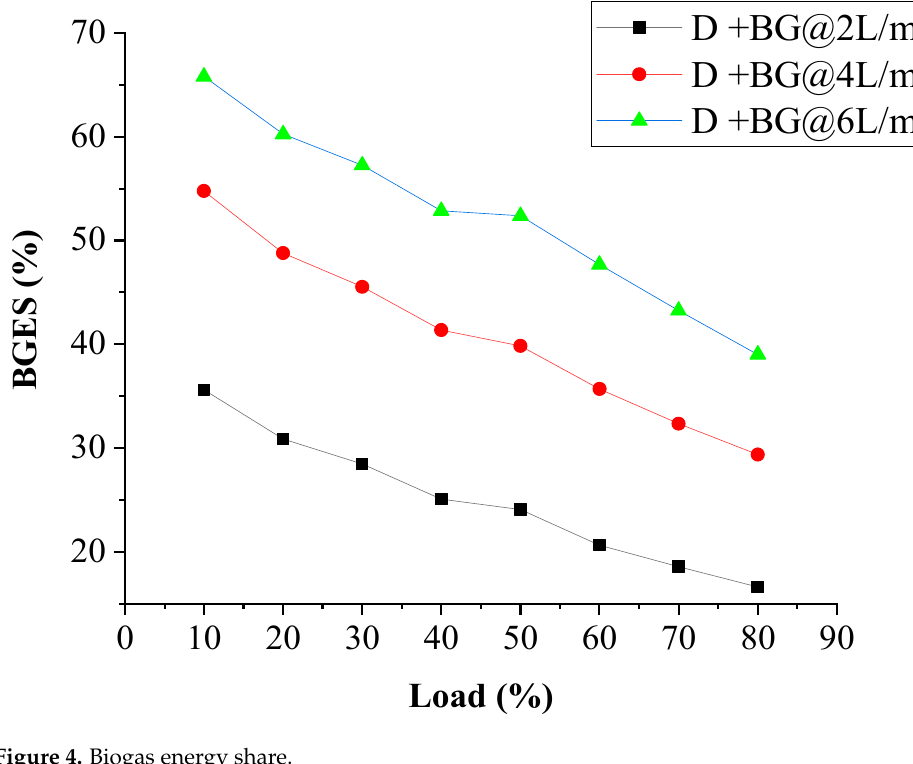
Figure 4. Biogas energy share.